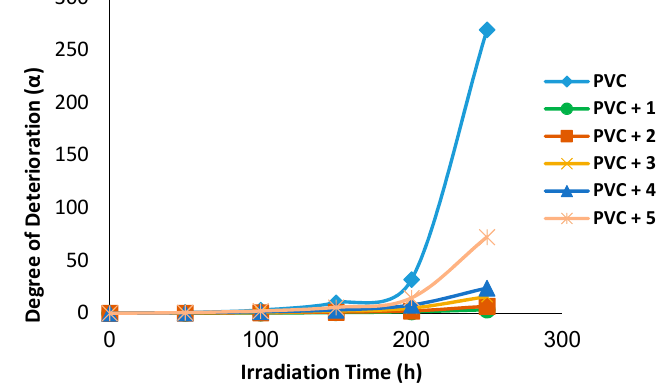
Figure 10. The relationship between the irradiation time (h) and main chain scission (S) for PVC films (30 µ m thickness) with Schiff’s bases 1 – 5 (0.5% by weight) as additives. In the initial stages of photodegradation, randomly distributed weak bonds can be broken quickly [37]. The degree of deterioration ( α ) was calculated by the use of Equation (10). (cid:2009) = (cid:1865).(cid:1845)/(cid:1839)(cid:3365) (cid:3023) where m = the initial molecular weight. Figure 11 shows the relationship between the irradiation time and degree of deterioration ( α ). Clearly, the α values for the irradiated PVC samples with Schiff’s base additives were lower compared to the case where no additive (blank) was used. The α values were found to be increased rapidly with irradiation time in the initial stages of photodegradation of PVC films, which could be due to a random polymeric chain bonds breaking.